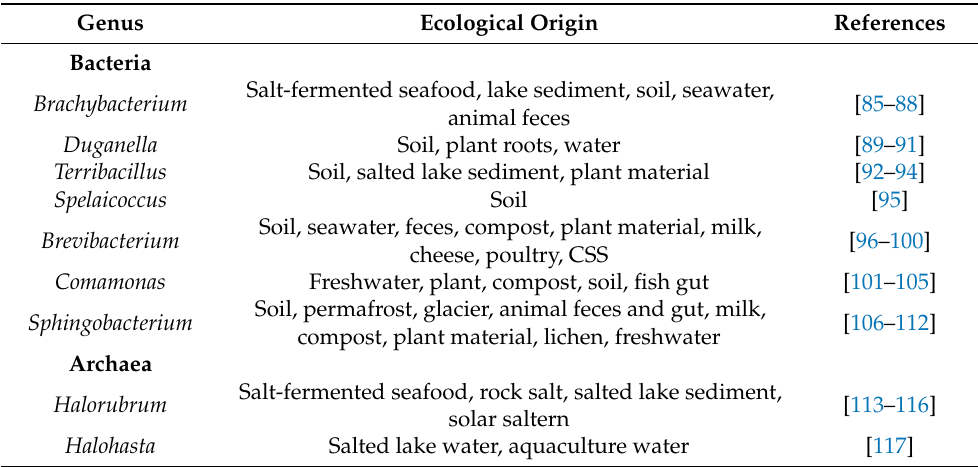
Table 3. Ecological origin of uncommon genera that were only detected using the metabarcoding approach in salmon dill